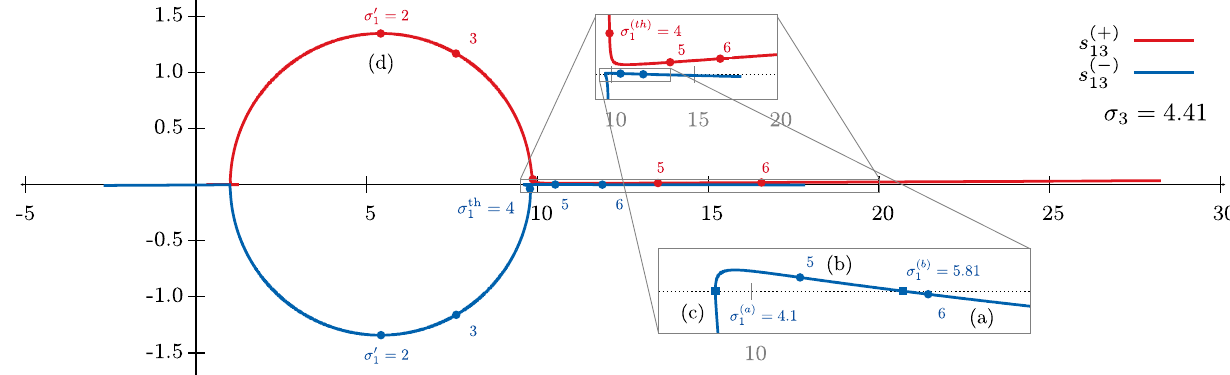
( − ) curvecrossestherealaxisatthepoints σ malregionwhere s 13 ( b ) = 5 . 81. The labels a – d indicate the regions described in the and σ 1 text and depicted in Fig. 10